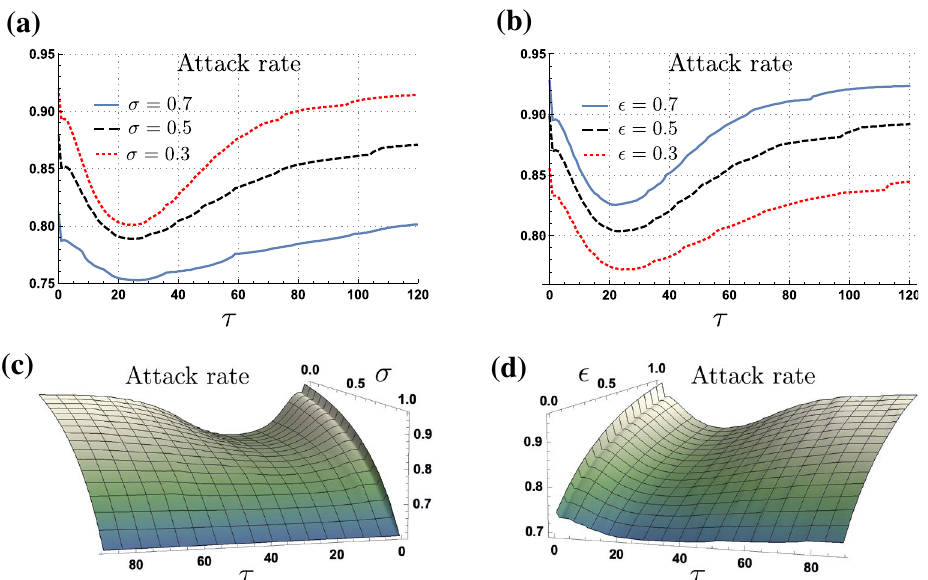
Figure 5. Attack rate as a function of the planning horizon for different proportion of asymptomatic cases and their relative infectiousness, under adaptive behavior model. Panels ( a ) and ( b ) show the non-monotonic effect of increasing the planning horizon on the attack rate, under variations of the proportion of asymptomatic cases and their relative infectiousness, respectively. Panels ( c ) and ( d ) shows the attack rate as a function of the planning horizon and the proportion of asymptomatic cases, and their relative infectiousness, respectively. For τ between 20 and 25 days the attack rate is minimized for all σ and ǫ